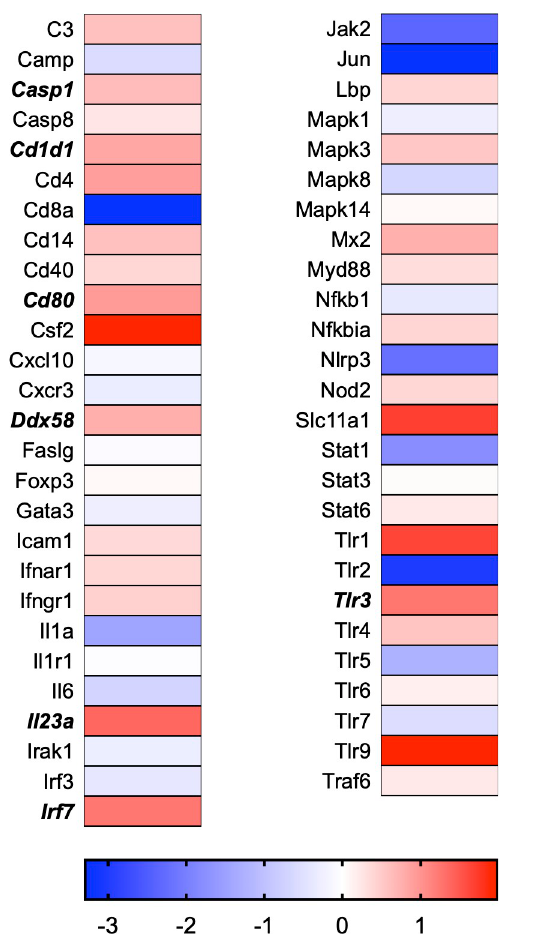
Fig 15. Innate and adaptive immunity heat map. Bold text indicates significantly altered gene